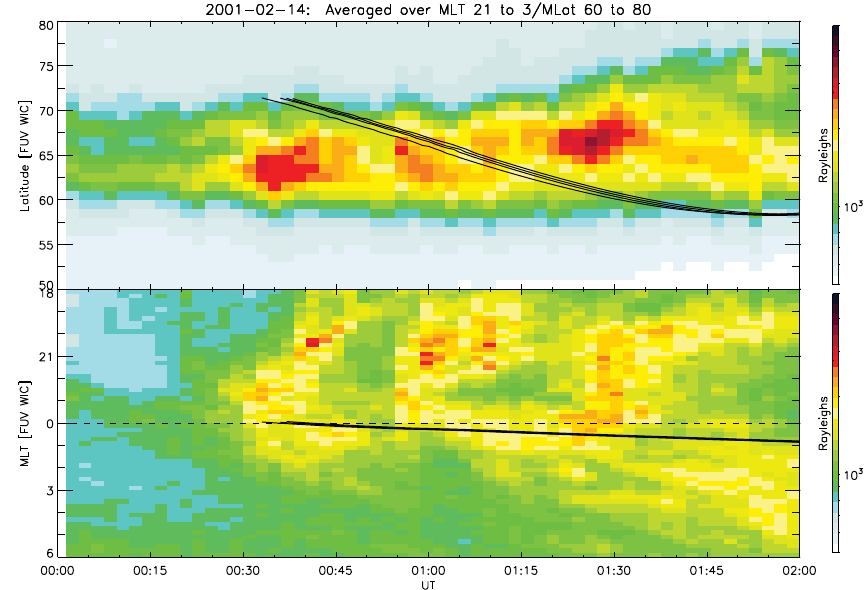
Figure 2. Keogram of global auroral images during the observations of ion beams flowing out of the ionosphere. The top panel shows the aurora in geomagnetic latitude as a function of universal time and the bottom panel shows magnetic local time vs. universal time. The right color bar shows the intensity of the aurora in rayleighs. The black lines are footprints of the satellite using several different models (caveat: Cluster was in the Southern Hemisphere, while the auroral picture comes from the Northern